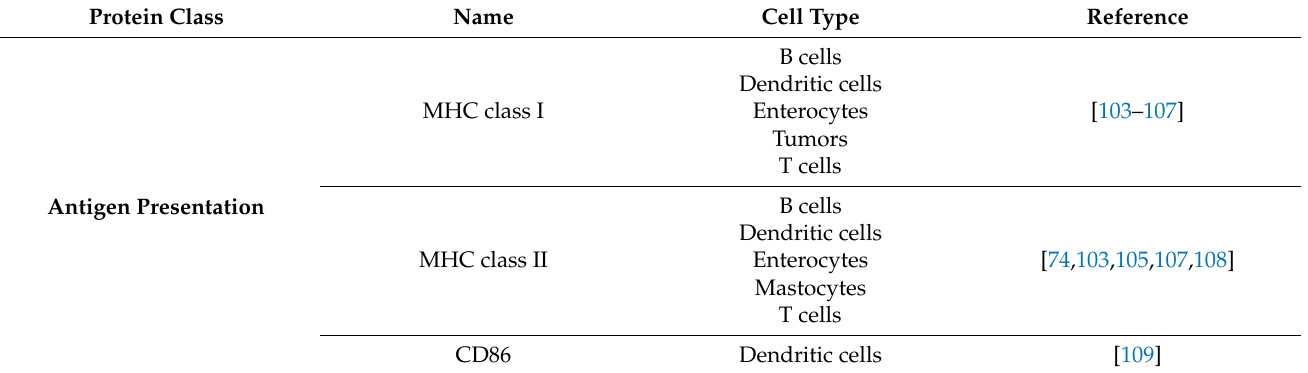
Table 2. Distinct protein families identified in exosomes from different cell